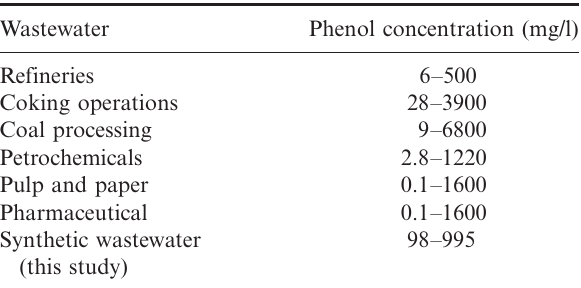
Table 1. Phenol concentration in various industrial